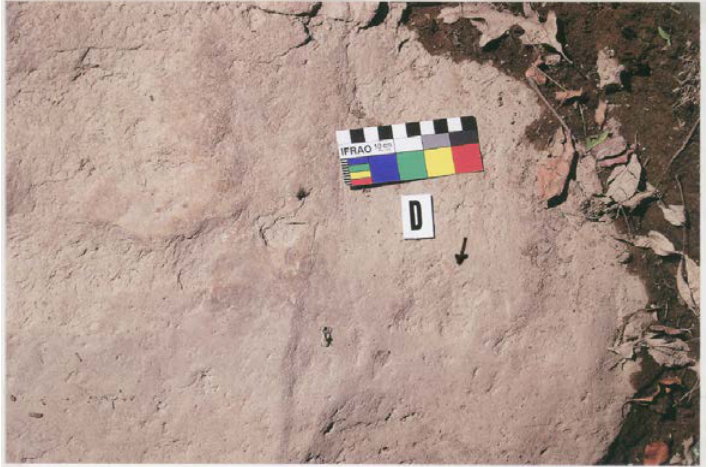
Figure 9. The remains of marking beneath all strata in the Hensler excavations. There are four areas of acutely weathered peck marks. Arrow points to an extremely weathered image, to some resembling a butterfly. Photo by author.